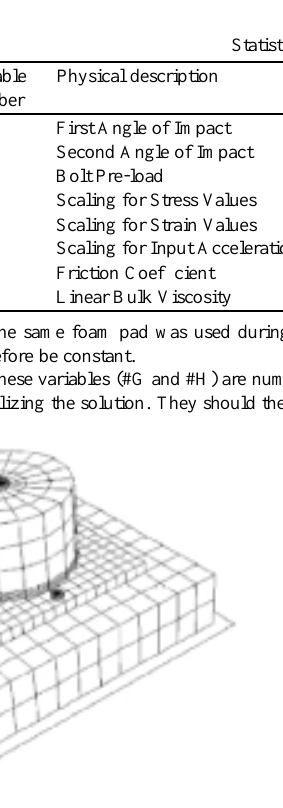
Fig. 5. 3D model of the LANL